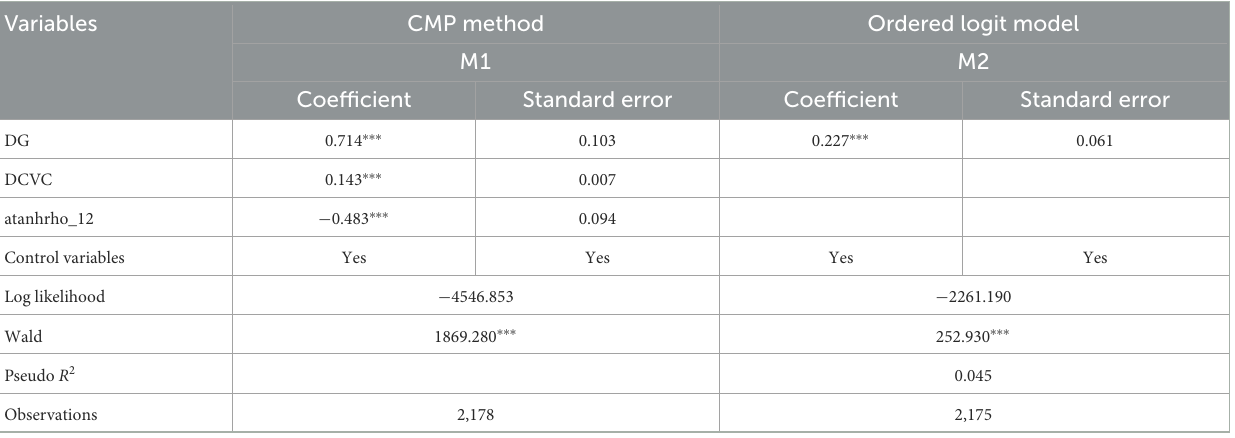
TABLE 6 Estimation results of robustness